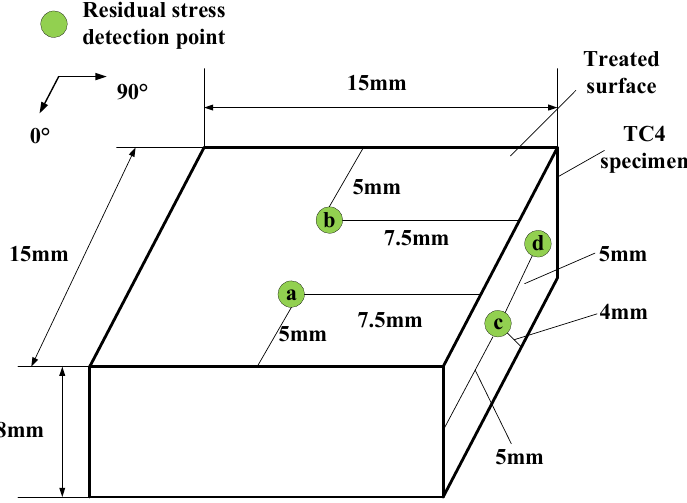
Figure 11. Test block size and X-ray stress detection point diagram.